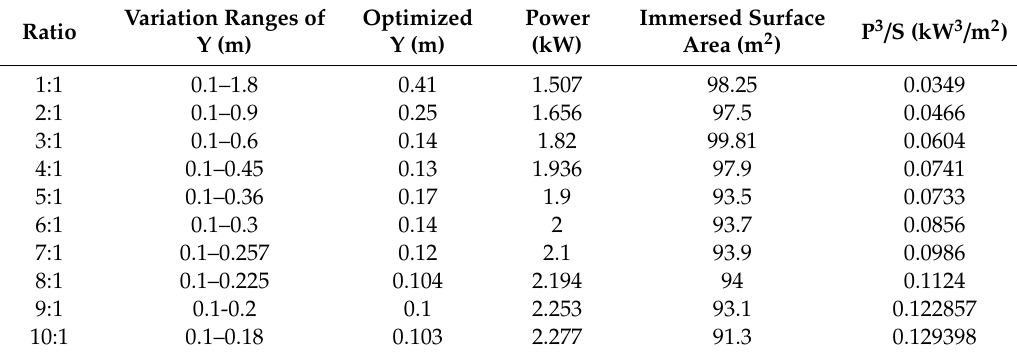
Figure 23. Description of the upside chamfered shape. Table 4. The optimized results for upside chamfered Table 4. The optimized results for upside chamfered shape.